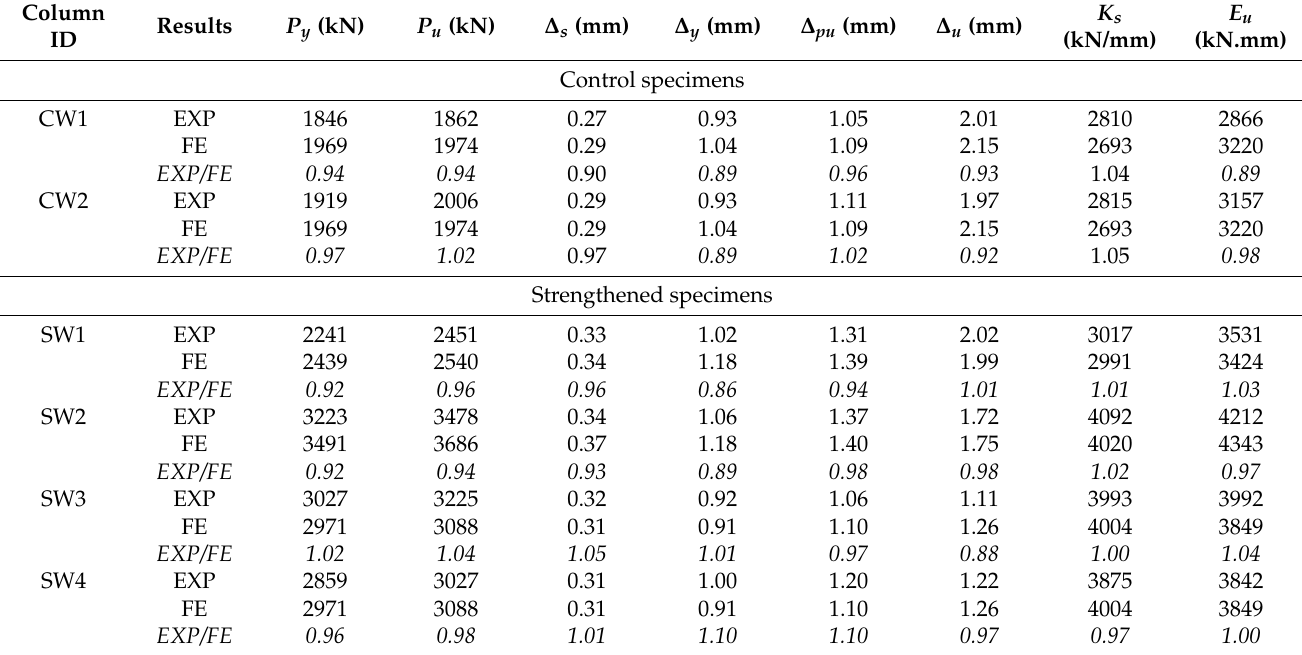
Table 3. Comparison of experimental and FE results of load-displacement response for test columns *.